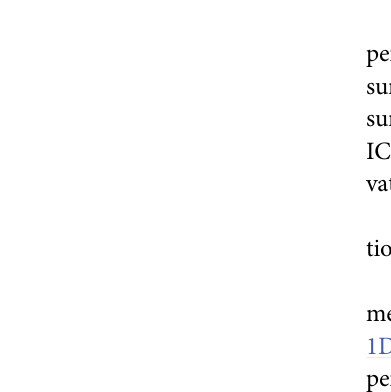
Table 2. Recurrence of periodontitis and non-surgical or surgical procedures performed during PMT (full-mouth, non-molar and molar) in RC and IC groups. Global sample RC (Individuals = 96; Teeth = 2,217; Sites = 8,868) n